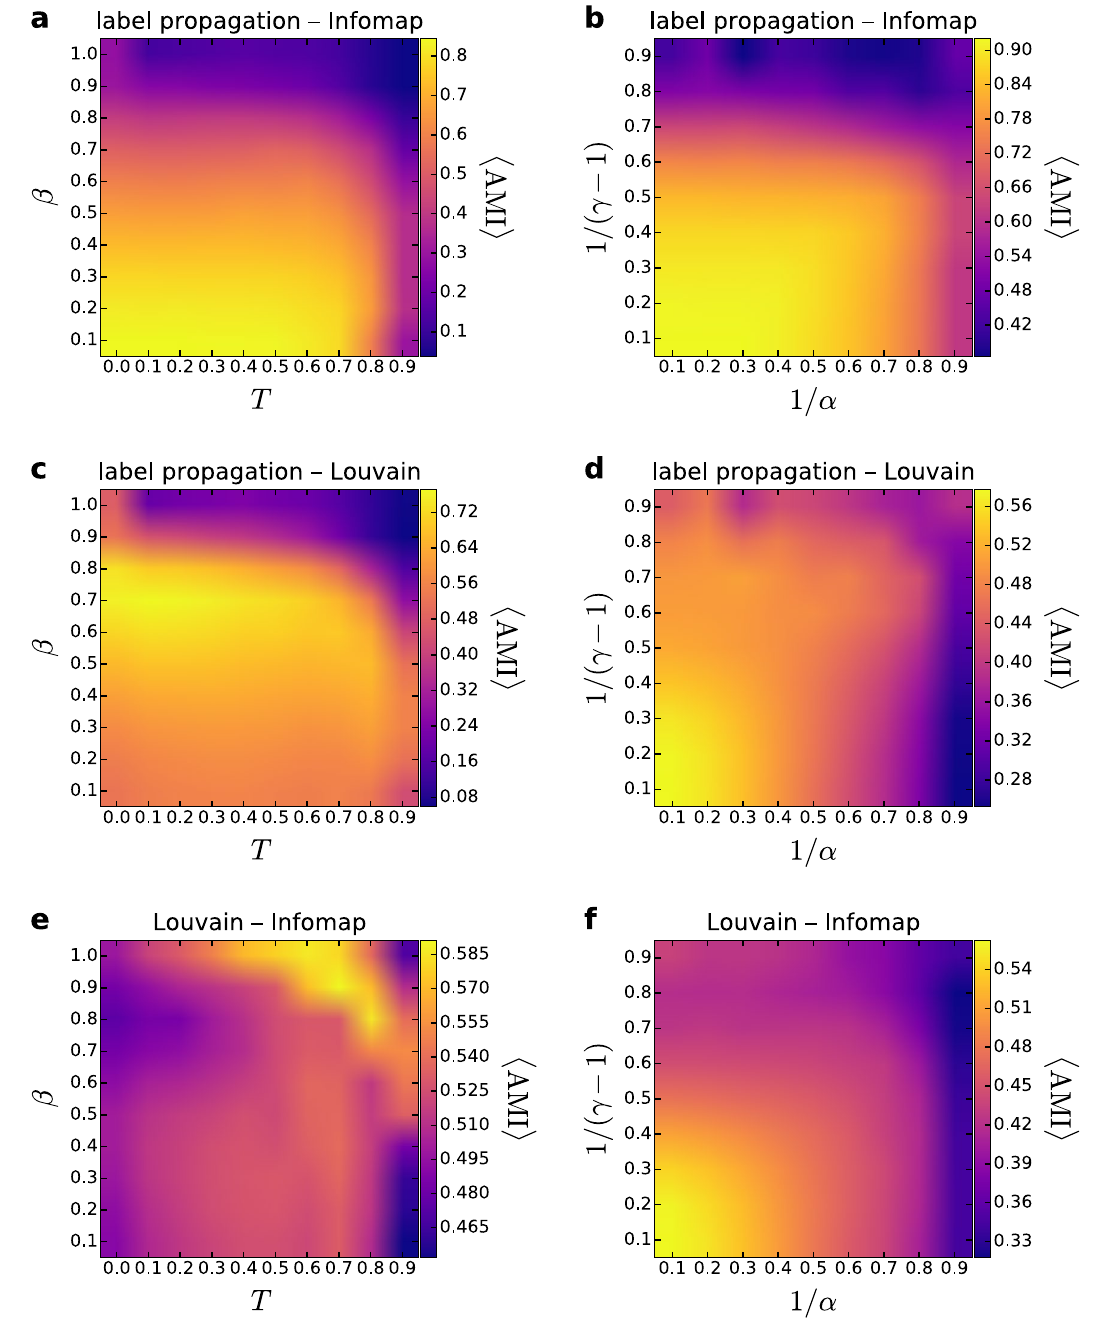
Figure 6. Adjusted mutual information between the different community partitions. The results for the PSO model are given in the left column ( a , c , e ), whereas the AMI obtained for the S 1 / H 2 model appears in the right column ( b , d , f ). The AMI between the communities detected by asynchronous label propagation and Infomap is given in the top row ( a , b ), the AMI regarding the results of asynchronous label propagation and Louvain is shown in the middle row ( c , d ) and the AMI between the partitions found by Louvain and Infomap is presented in the bottom row ( e , f ). We show the measured AMI (indicated by the color, averaged over 100 samples) as a 10,000 and expected 1 ) for networks of size N function of the model parameters T and β , or 1 /α and 1 /(γ = − k 10 average degree � � =